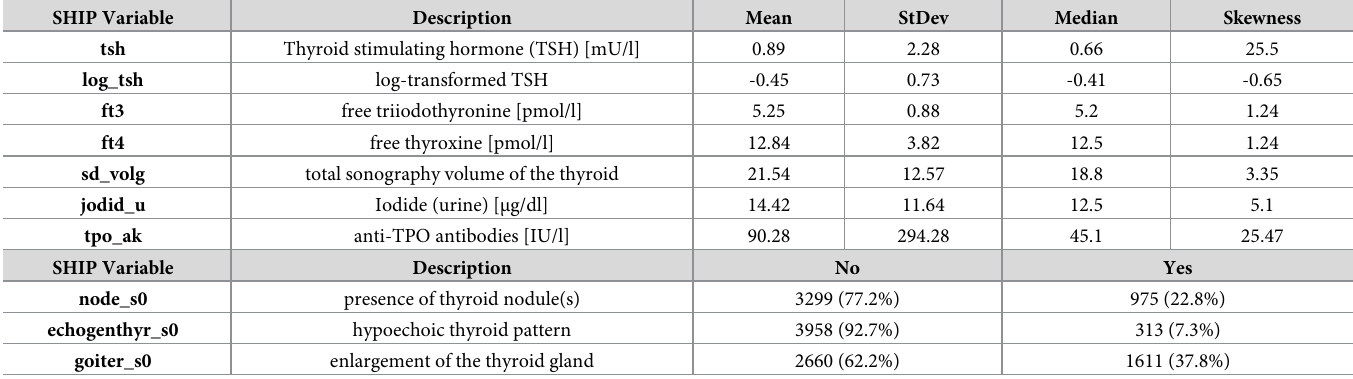
Table 2. Descriptive statistics of thyroid examination results from SHIP. Mean, standard deviation, median and skewness are presented for continuous features. For categorical features, the exact distribution is shown. The analysis is based on n = 3,989 probands.